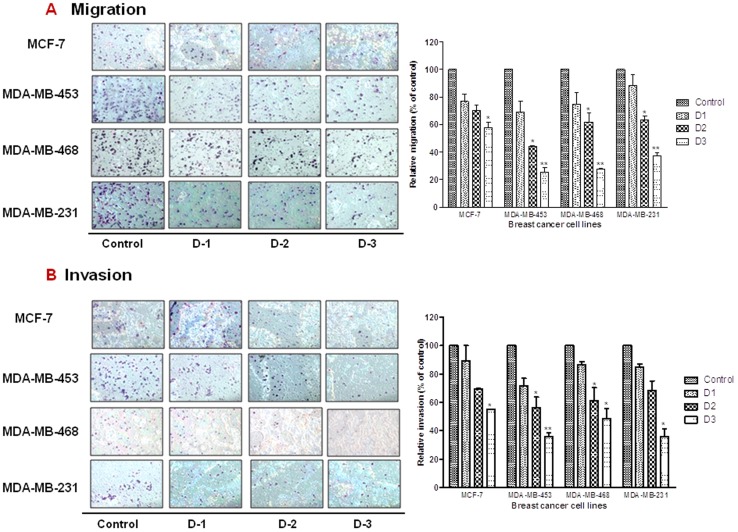
Panepoxydone decreases migration and invasion properties of breast cancer cells.MCF-7, MDA-MB-231, MDA-MB-468 and MDA-MB-453 cells were seeded on noncoated or matrigel-coated membranes for motility (A) and invasion (B) assays, respectively and incubated for 24 hrs. DMEM containing 10% fetal bovine serum in the lower chamber was used as a chemoattractant. After incubation, cells that had migrated or invaded through the membrane/matrigel to the bottom of the insert were washed, fixed, stained and counted in ten random microscopic fields. The histograms show mean of two independent experiments and the error bar represent SEM. * indicates statistically significant difference between PP treated and untreated cells at p<0.05 (*), p<0.01(**), and, p<.001(***) levels by student's t-test. Results indicate reduction in the migrated and invaded cells after PP treatment in a dose dependent manner.